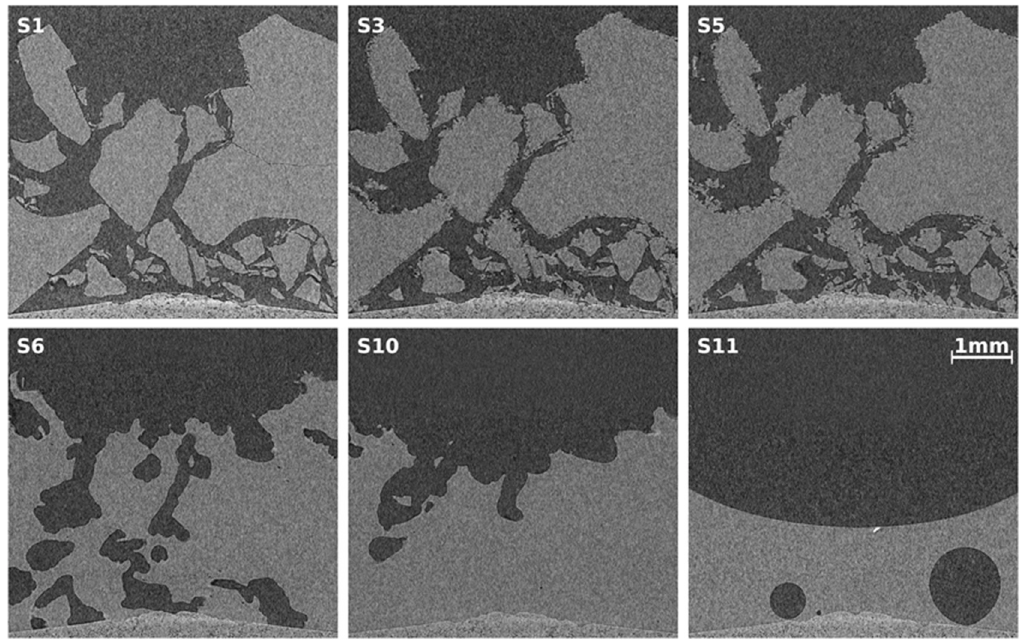
Figure 6. Tomographic images obtained from CT scans (numbered S1, S3, S5, S6, S10, and S11) of the THF clathrate sample at different points in time. Each slice represents the exact same position in space. In S1–S5 the sample temperature is 247 K, in S6 it is 273 K, and in S10 it is 274 K. S11 shows the meniscus of the molten sample together with gas bubbles, which can be found all over the liquefied sample. The bright point in slice S11 stems from a tiny metallic particle.